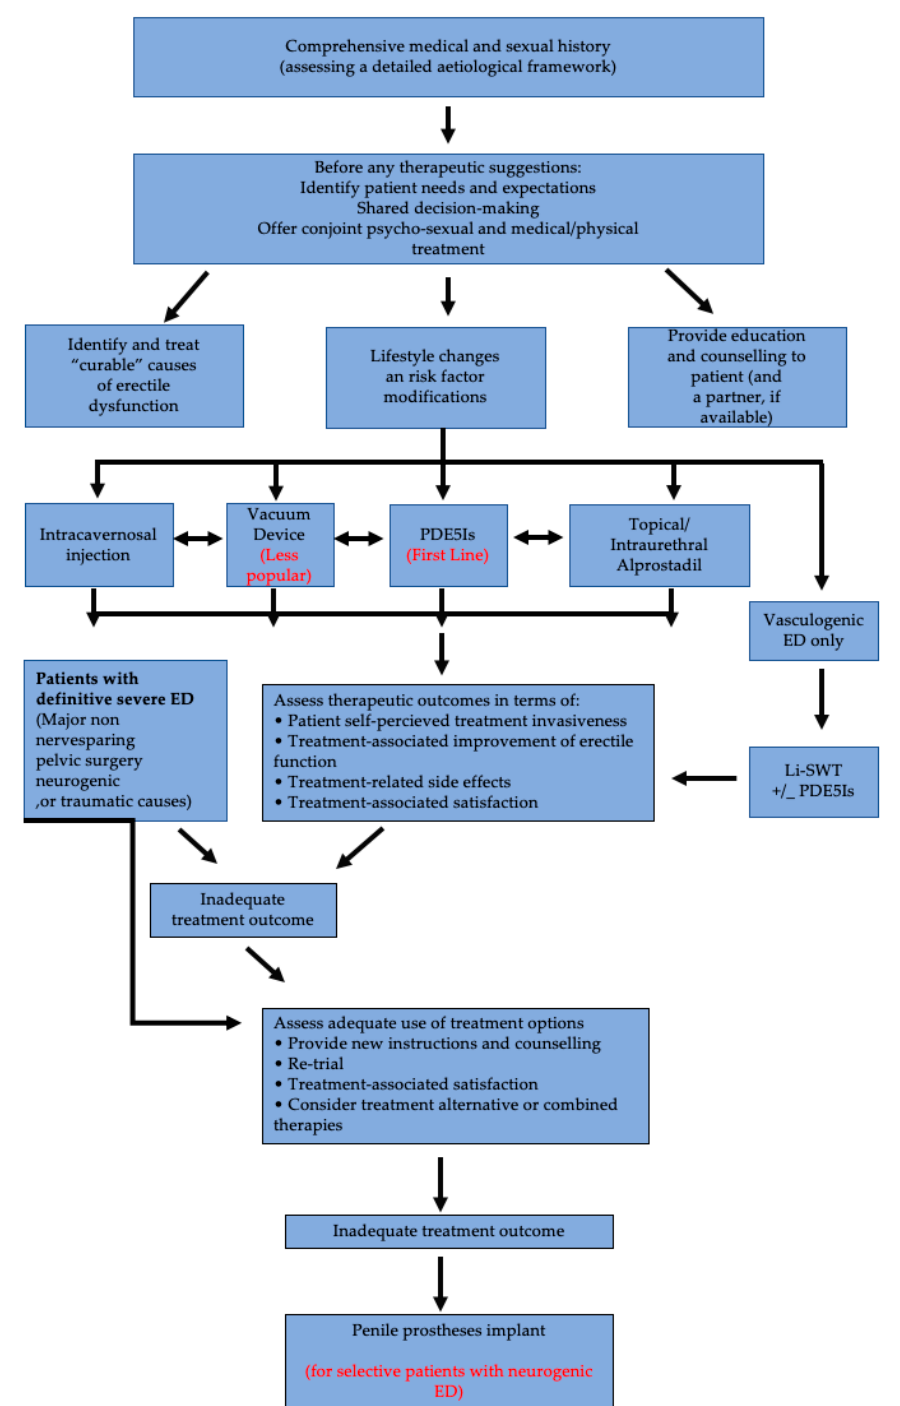
Figure 1. Management algorithm for ED. Adapted from EAU Guidelines on Sexual and Reproductive Health 2020